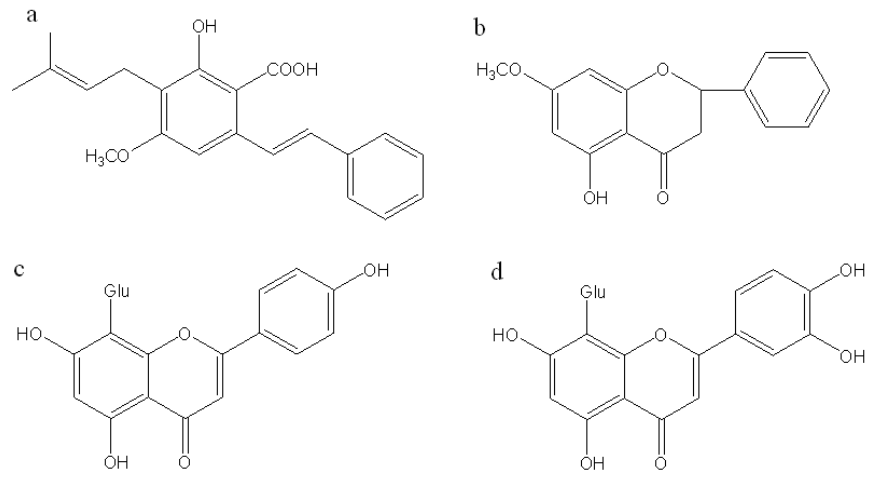
Figure 1. Chemical structures of (a) cajaninstilbene acid, (b) pinostrobin, (c) vitexin and (d) orientin. Glu: